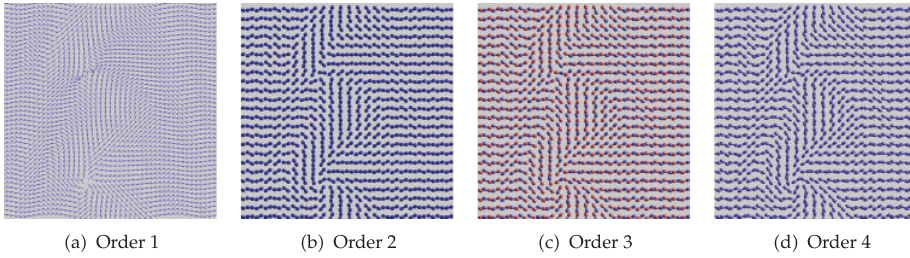
Figure 13: Synthetic tensor fields.